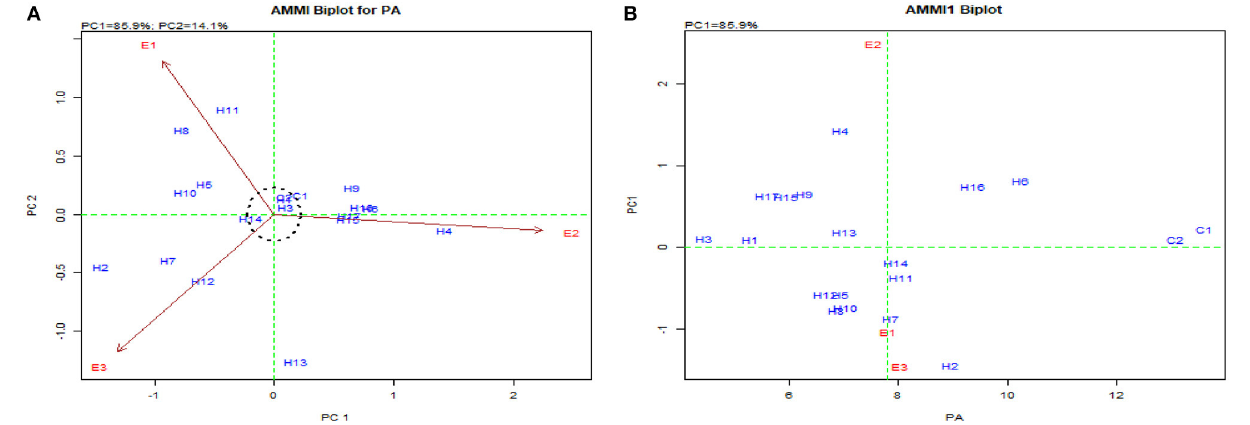
FIGURE 5 | AMMI biplot for PA in the hybrids. (A) AMMI biplot PC1 vs. PC2 for PA and (B) AMMI biplot for the mean of PA vs. PC1.